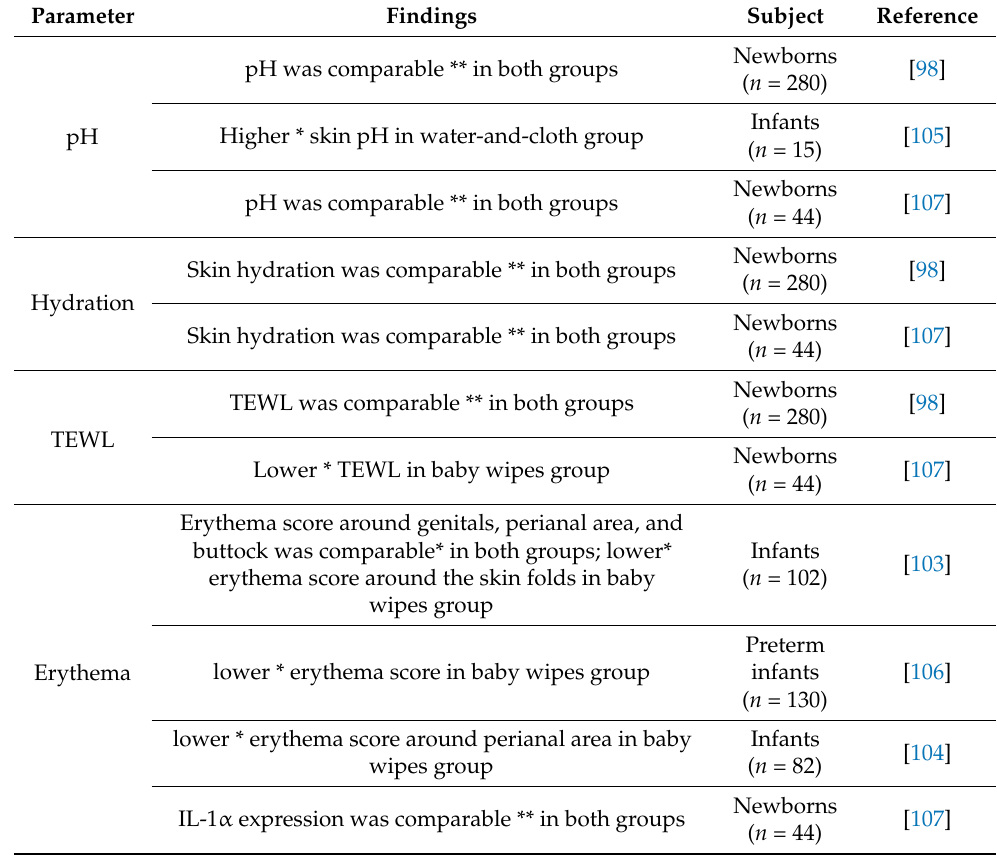
Table 4. Summary of clinical studies comparing the use of baby wipes versus water and wool/cloth. Parameter Findings Subject